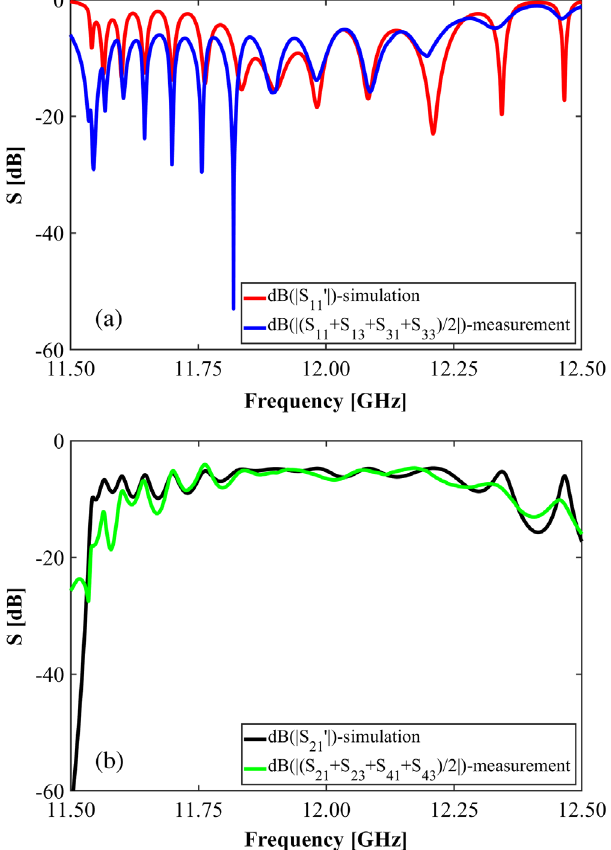
FIG. 28. Comparison between simulated and measured S parameters [(a) S 0 11 and (b) S 0 21 ] for the full-assembly structure ¼ 2 . 99 mm, W ¼ 2 . 08 mm at one side and W with R 1 in 2 . 12 mm at the other side.